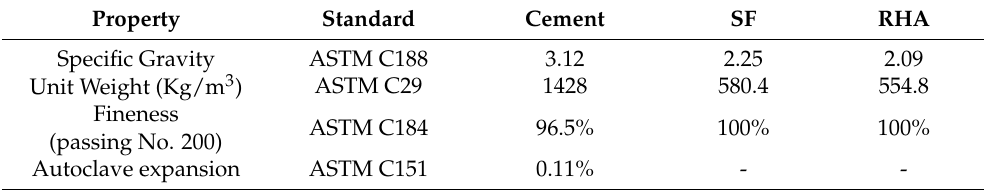
Table 3. Physical Properties of Cement, Silica Fume, and Rice Husk